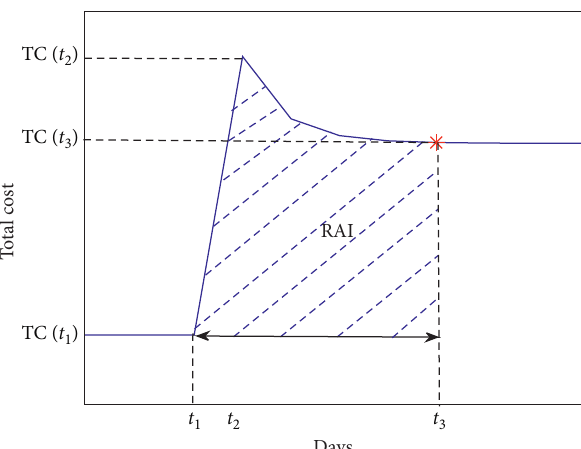
Figure 2: Evolution of the total travel cost before and after the disruption.